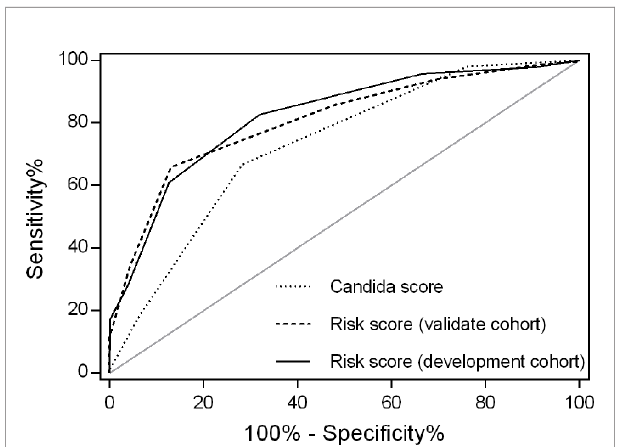
FIGURE 3 | Calibration plot of observed versus predicted risk for IC at the onset of infection. Hosmer-Lemeshow chi-squared statistic is shown for the risk score in both the development and validation cohorts. The points and circles indicate the observed frequencies by sextile of predicted probability.